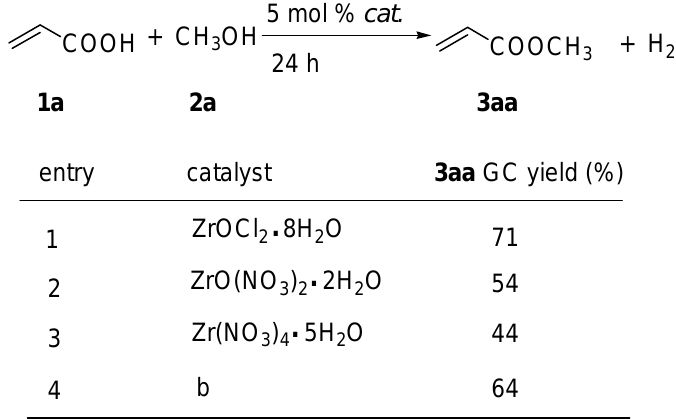
Table 1. Zirconium compounds-catalyzed esterification of acrylic acid 1a with methanol 2a